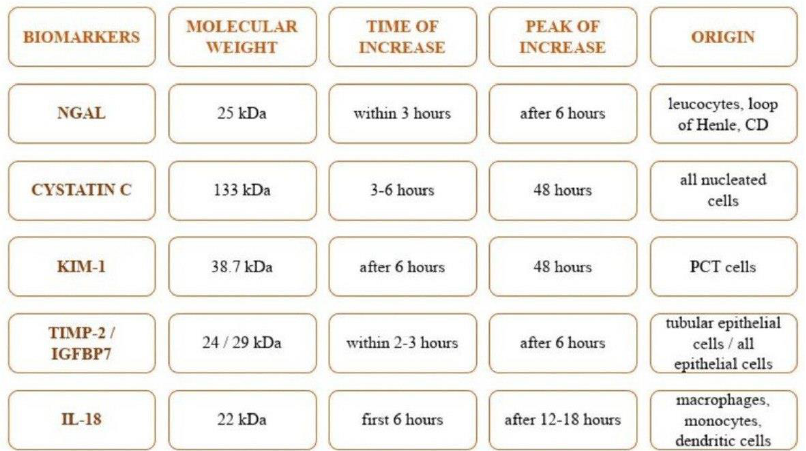
Figure 3. The main feature of usual biomarkers used in burn-induced AKI diagnosis. Notes: Levels are measured in urine. NGAL—neutrophil gelatinase-associated lipocalin; KIM-1—kidney injury molecule-1; TIMP-2—tissue inhibitor of metalloproteinase-2; IGFBP7—insulin-like growth factor- binding protein; IL-18—interleukin-18; PCT—proximal convoluted tubule, CD—collecting duct.